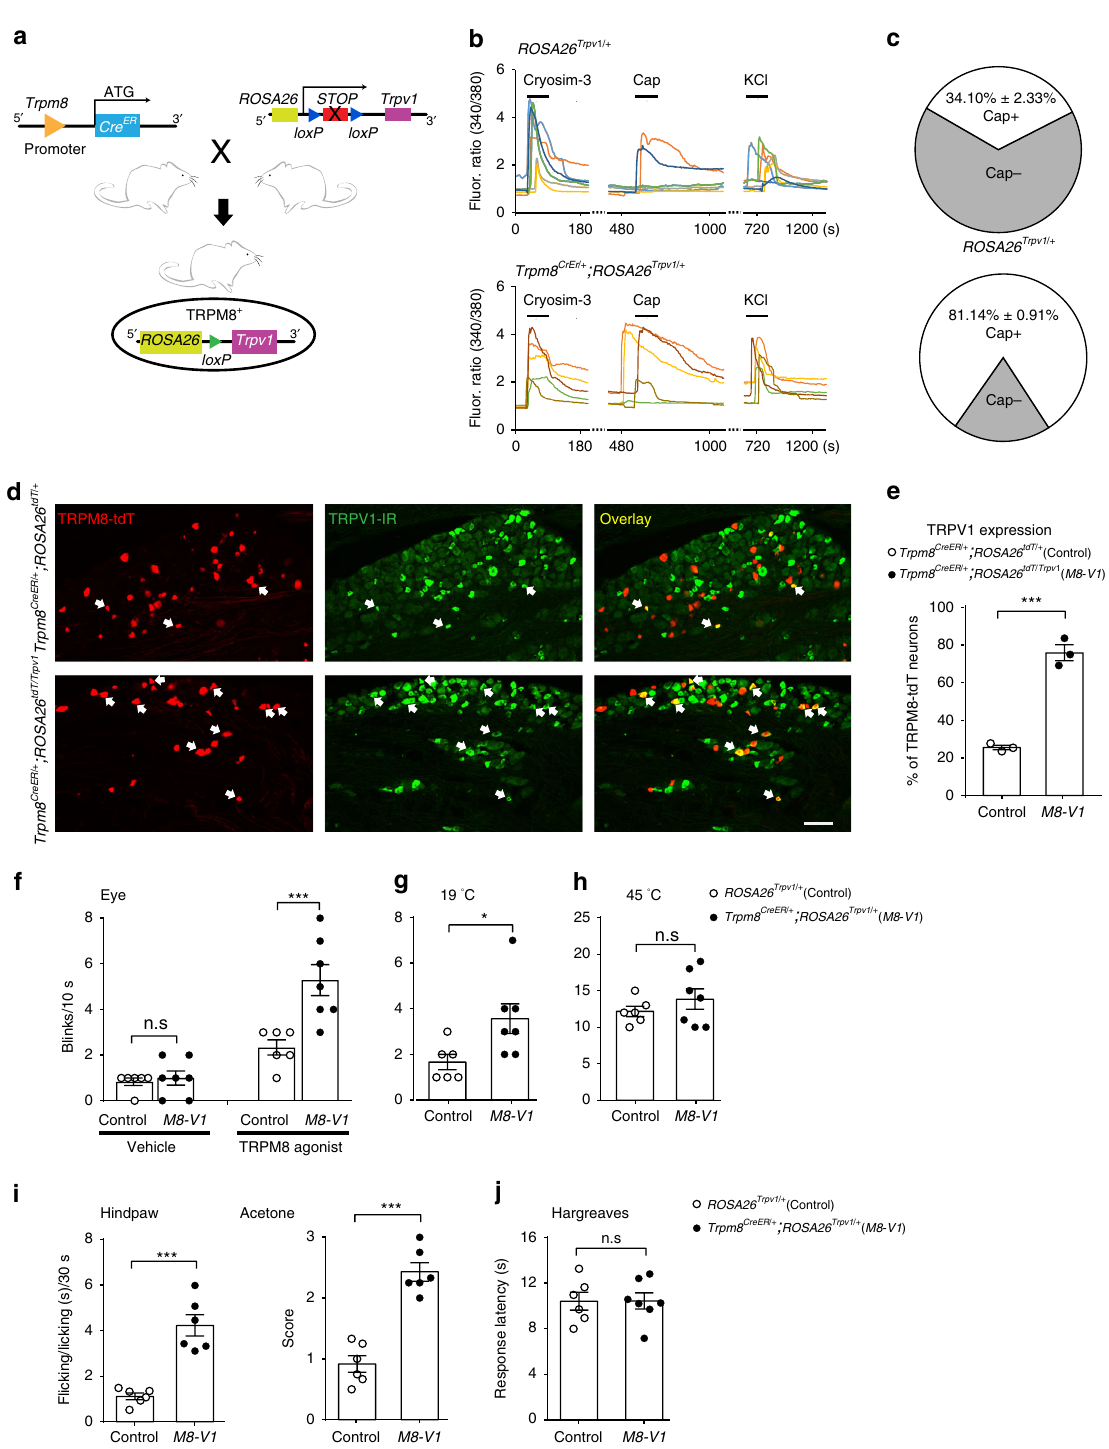
WGA-AF555 from the cornea. Single cell RT-PCR indicated that all TRPM8 + ; TRPV1 + neurons express substance P ( Tac1 ), while fewer TRPM8 + ; TRPV1 - neurons express Tac1 (Fig. 7b). To determine whether substance P is a neurotransmitter for signaling ocular cold nociception, we examined the release of substance P after cold stimulation of dissociated sensory neurons (bath temperature drop from 32 °C to 15 °C). Indeed, cold induces a signi fi cant release of substance P (Fig. 7c). This release was suppressed by pre-desensitization of TRPM8 + neurons using cryosim-3 (Fig. 7c), substantiating the release of substance P